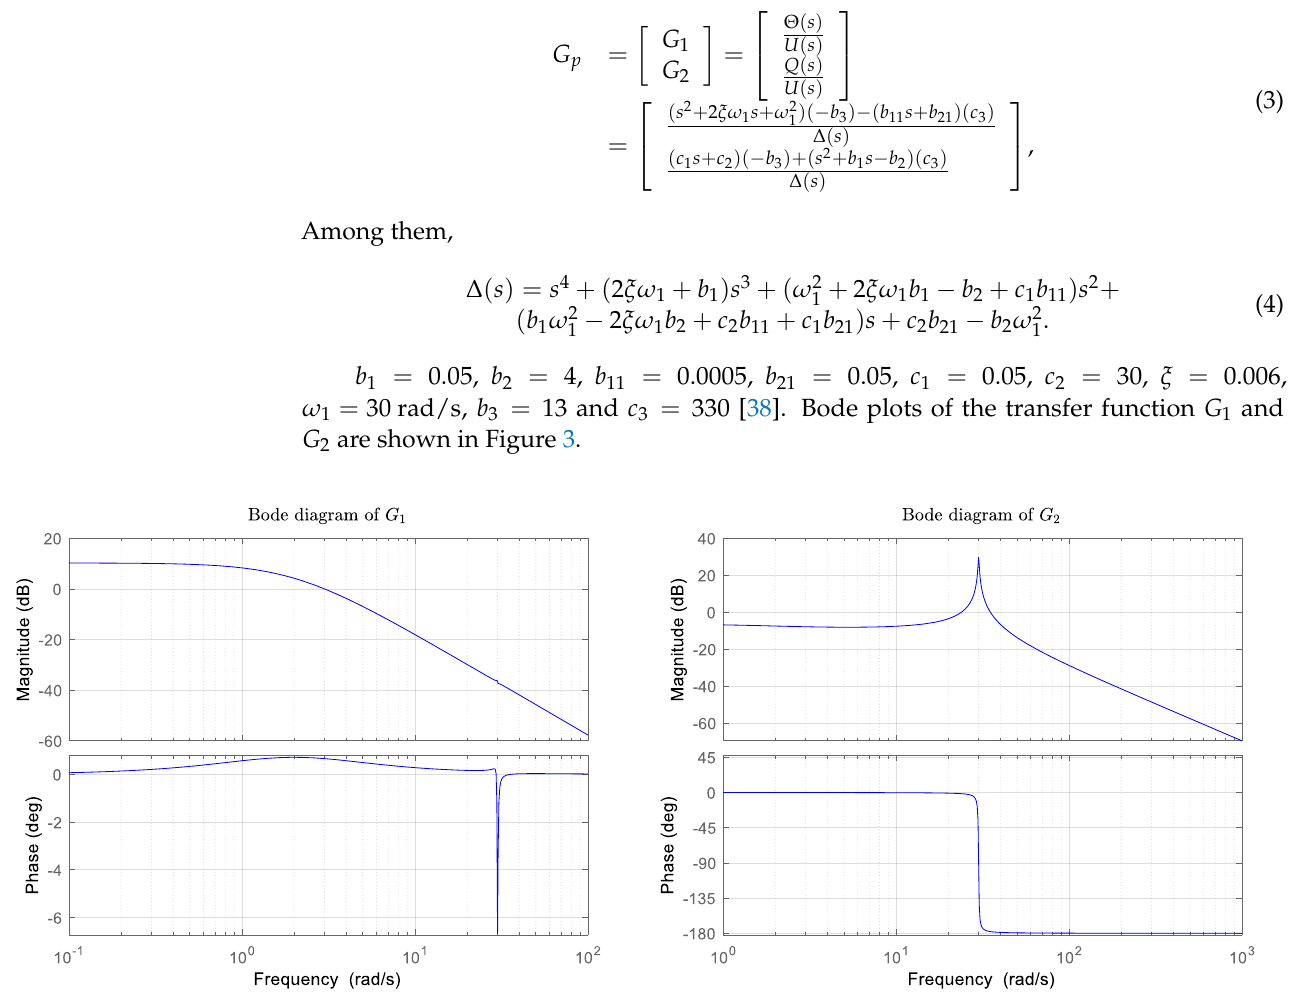
1 ; ( b ) the Bode plot of the G 2